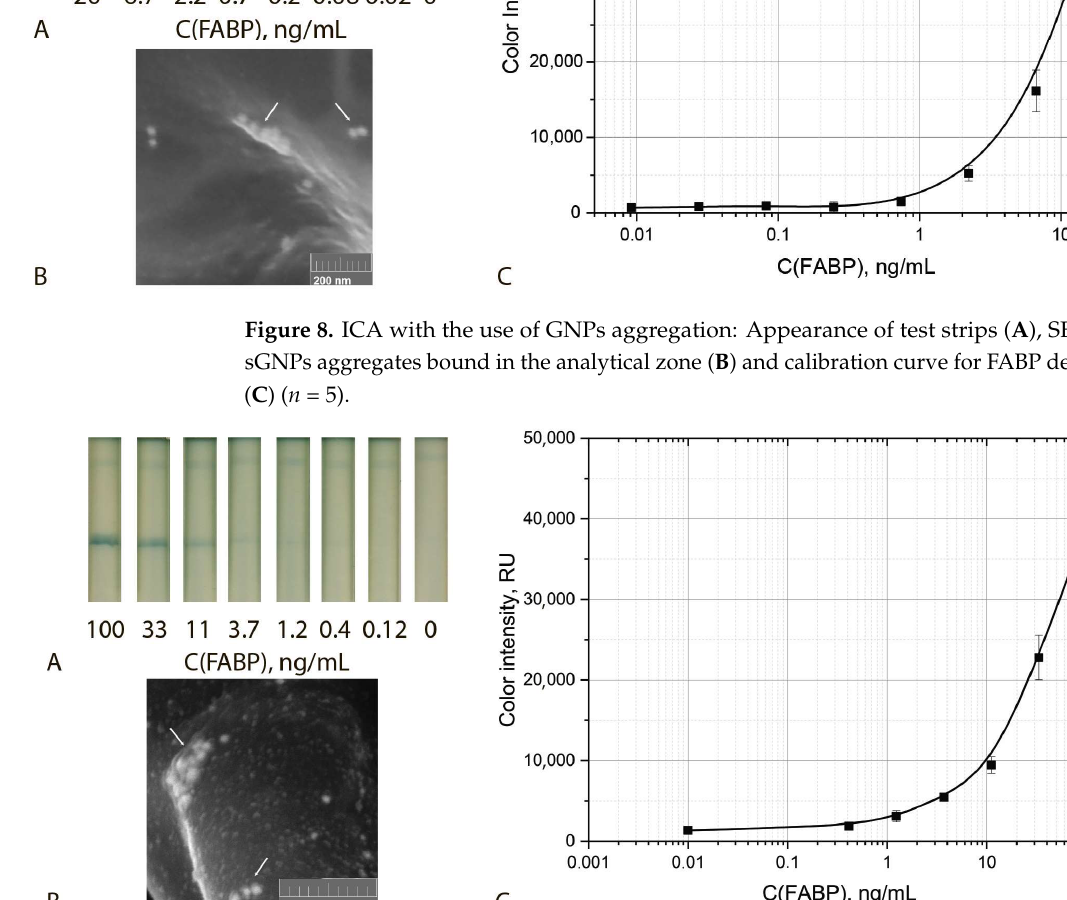
Figure 8. ICA with the use of GNPs aggregation: Appearance of test strips ( A ), SEM image of the sGNPs aggregates bound in the analytical zone ( B ) and calibration curve for FABP detection in se- rum ( C ) ( n = 5).